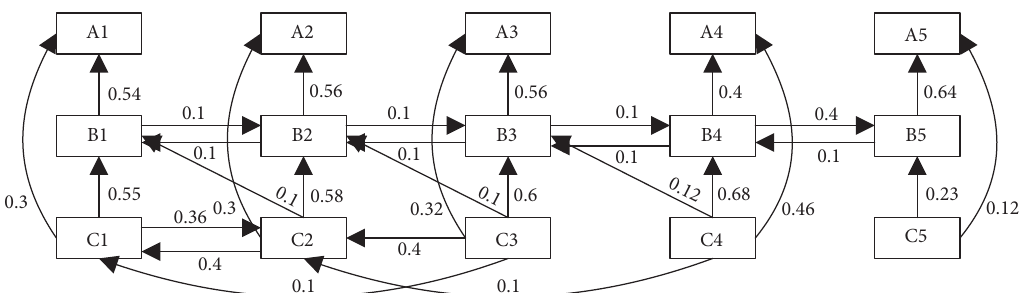
Figure 9: The diagram of spatial units in the section area of the entrance and exit.